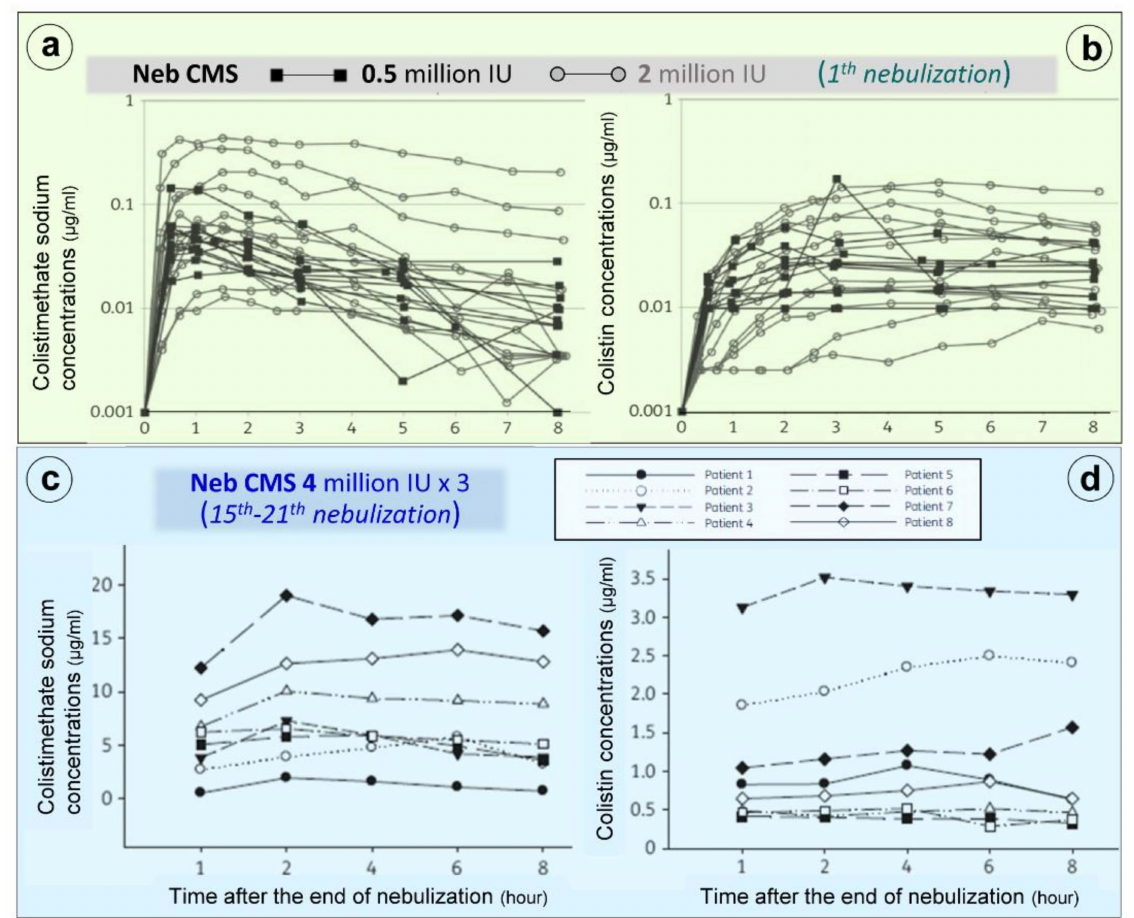
Figure 7. Colistimethate sodium (CMS) and colistin plasma concentrations following nebulization of various doses of CMS. ( a , b ) Plasma concentrations measured following the initial nebulization of CMS 0.5 and 2 million IU in a series of twelve patients with ventilator-associated pneumonia caused by Gram-negative bacteria [79]. ( c , d ) Plasma concentrations measured after 2–7 days of CMS nebulization at a dose of 4 million IU three times a day in a series of eight patients with ventilator-associated pneumonia caused by multidrug-resistant Gram-negative bacteria. Plasma concentrations were measured by high-performance liquid chromatography in the 8 h following an individual nebulization